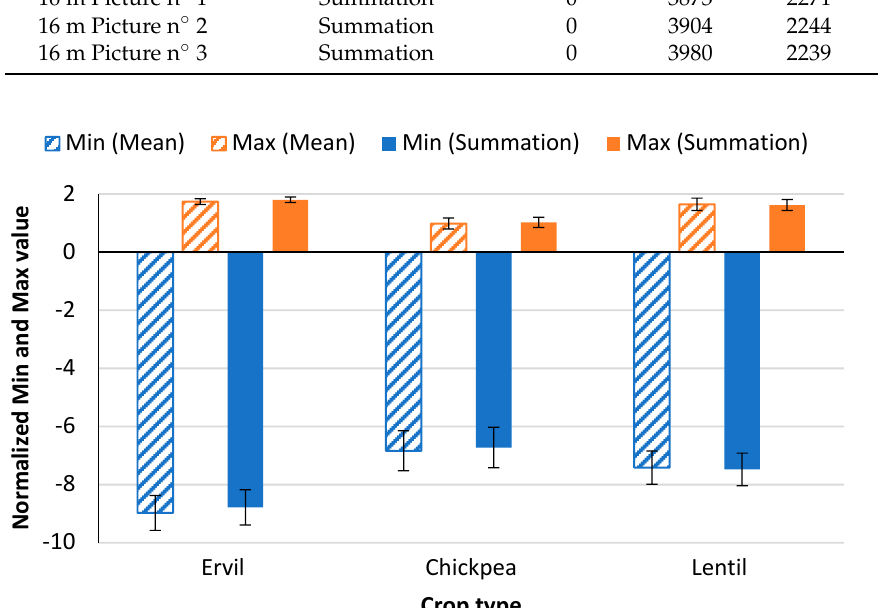
Figure 6. Comparison of normalized mean values and standard deviation of intra-crop data variability of each crop for the summation and mean aggregation operators.